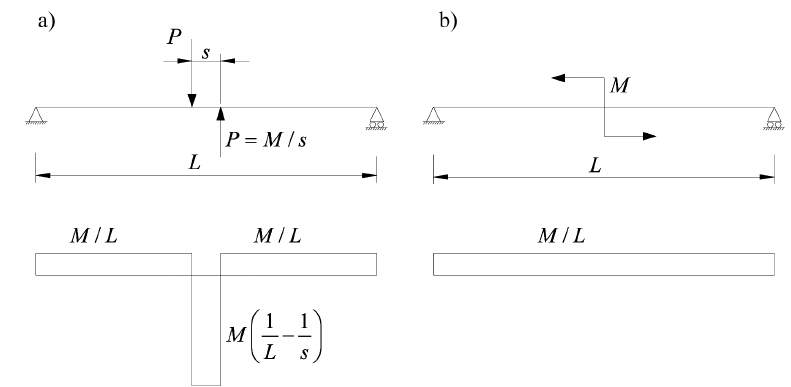
Fig. 2. Concentrated couples formed by: a) the vertical forces causing signi fi cant shear forces, and b) the horizontal forces – no signi fi cant shear forces [10]. The concentrated bending moment can be applied in two ways – by the vertical force couple (Fig. 2a) or by the horizontal force couple (Fig. 2b). With the former, a large shear force is generated at mid-span of the beam. The force increases as the distance between the forces s decreases. To correctly represent the beam deformation in this case, it is necessary to consider transverse shear strains, regardless of the beam thickness. The same situation occurs when such loading conditions are applied to plates and